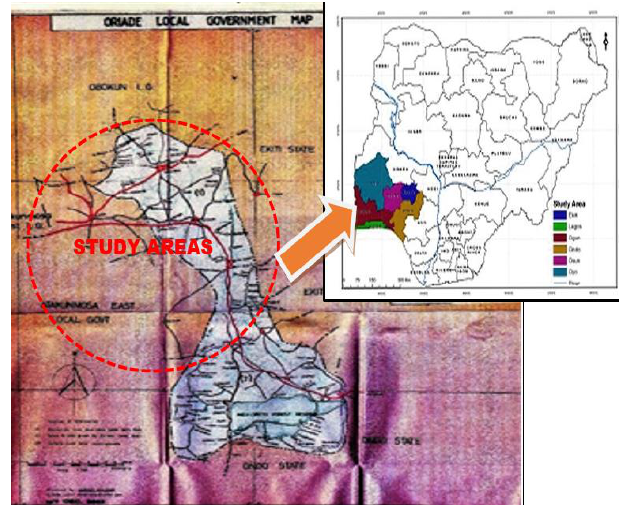
Figure 4. Map of the study areas and its position in Nigeria. Source: Agboola et. al., (2018) and www.google.com